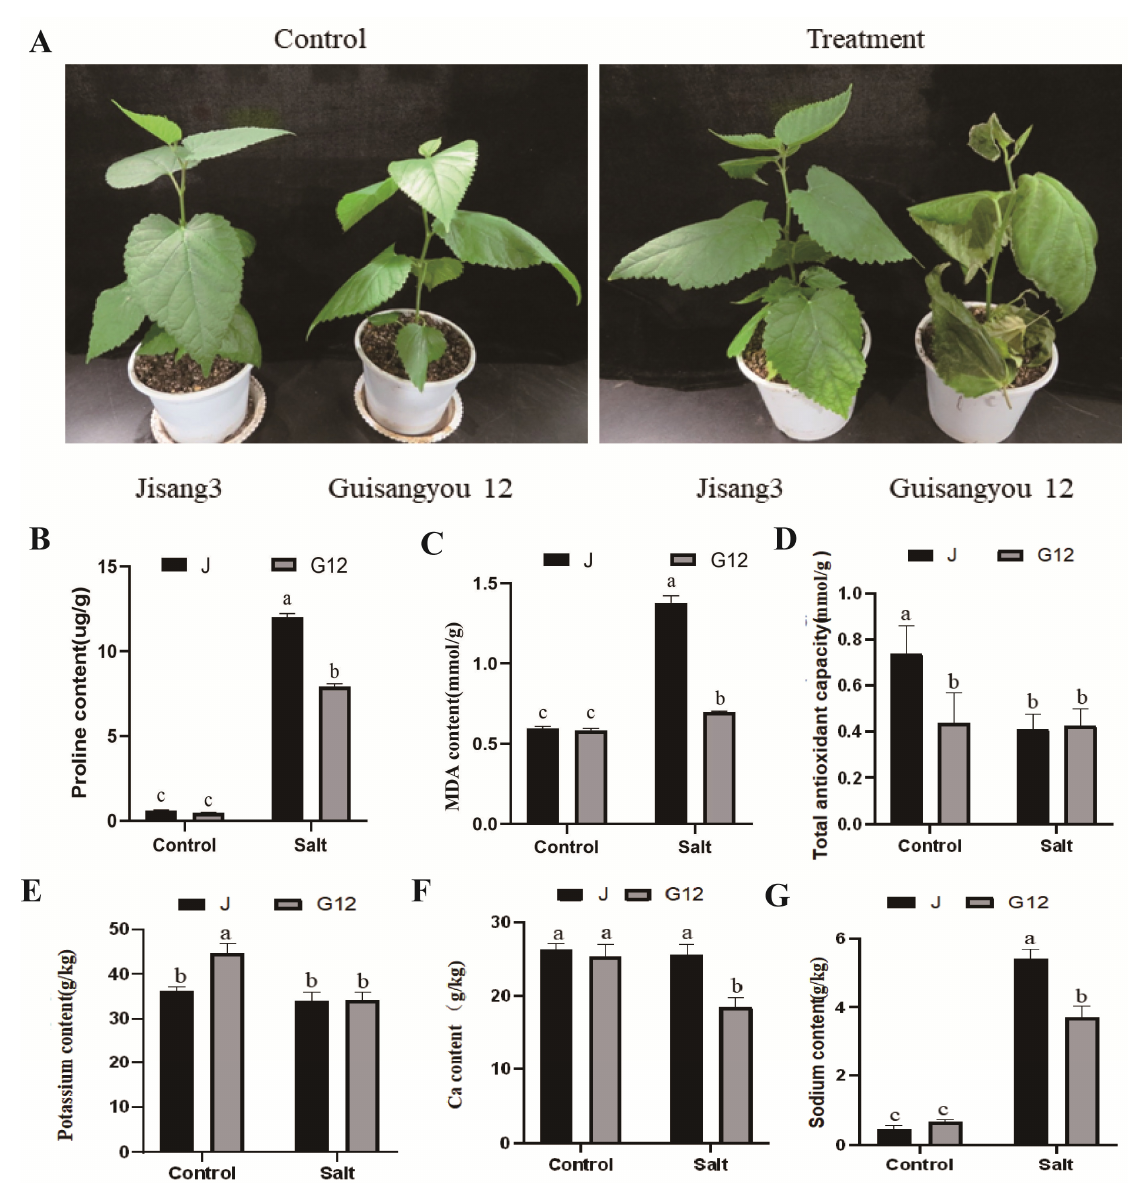
Figure 1. Phenotypic and physiological characteristics of mulberry varieties Jisang3 and Guisangyou12 under control and saline conditions. ( A ) Performance of Jisang3 and Guisangyou12 plants under control and saline conditions. ( B ) Proline content of root in both J and G12 groups. ( C ) MDA content of root in both J and G12 groups. ( D ) Total antioxidant capacity of root of the two varieties in saline condition. ( E – G ) Ion content (potassium, calcium, sodium) of root of mulberry varieties Jisang3 and Guisangyou12 under control and saline conditions. Data are means ± SD with three biological replicates. Different letters represent statistically significant differences between control and salt treated plants by Duncan’s multiple range test ( p < 0.05). Jck, JS, G12ck and G12S represent the two states of Jisang3 and Guisangyou12 under control and salt stress, respectively.